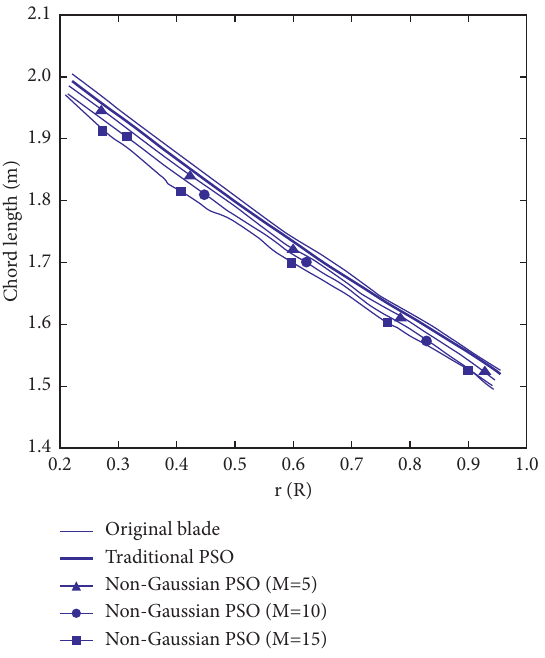
Figure 2: Comparison of blade chord.